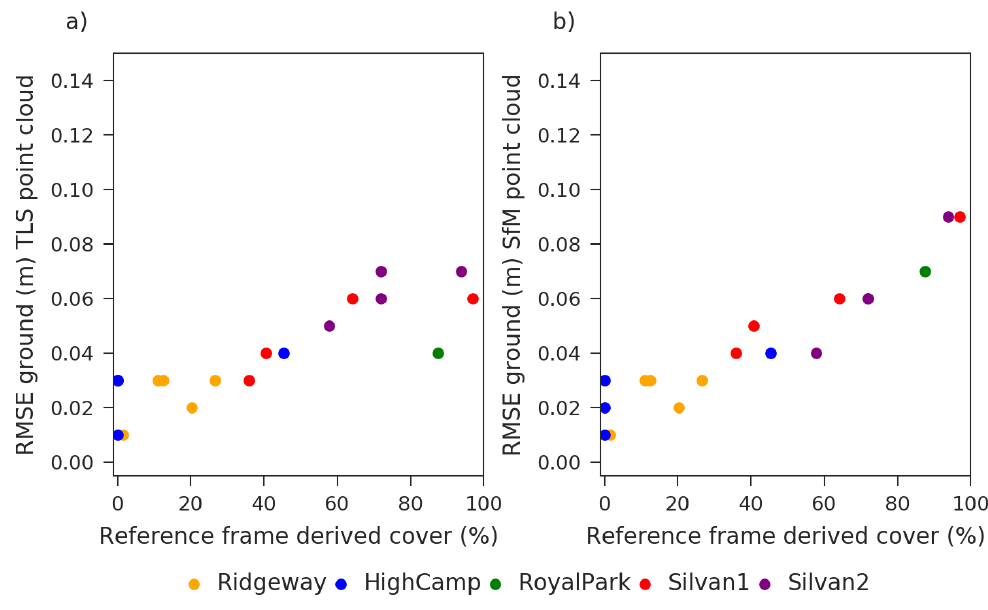
Figure 5. TLS ( a ); and SfM ( b ) point cloud RMSE of ground surface compared to cover derived from reference frame measurements. The error in the surface of the ground relative to cover percentage at each measurement point is demonstrated. Each site had multiple plots—for example, High Camp with four sites.